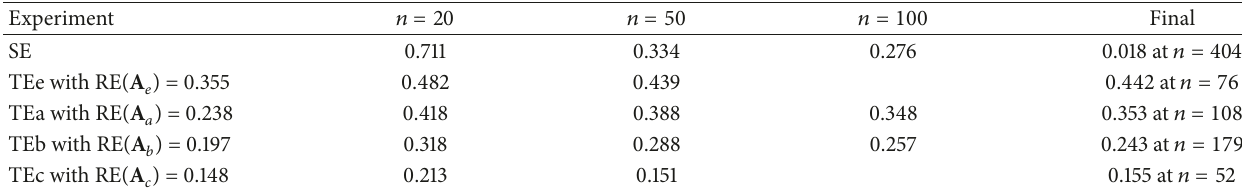
Table 2: As in Table 1 but for the second set of innovations with periodic extension.